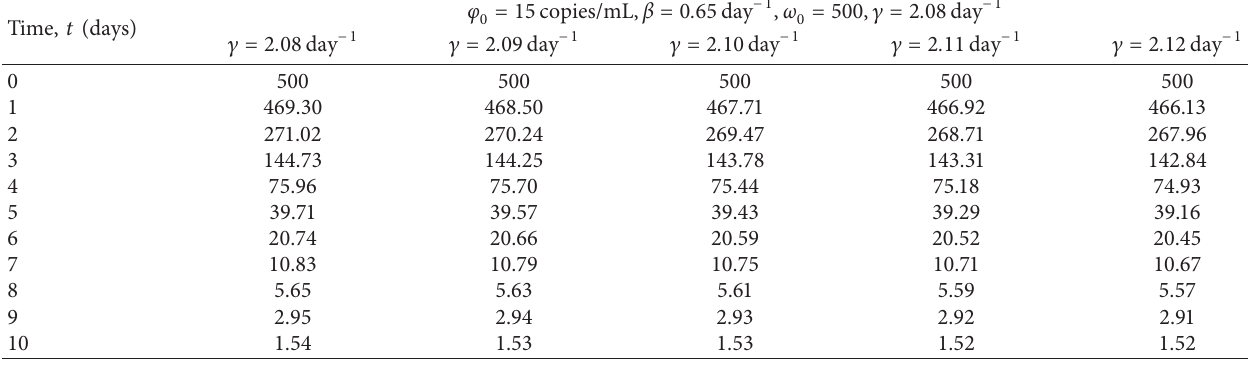
Table 7: The number of infected cells ω for different values of time t and rate constant of viral particle clearance c with